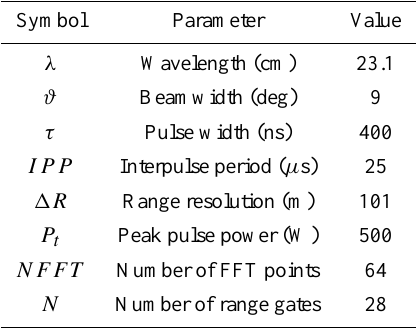
Table 1. Parameters set for the wind